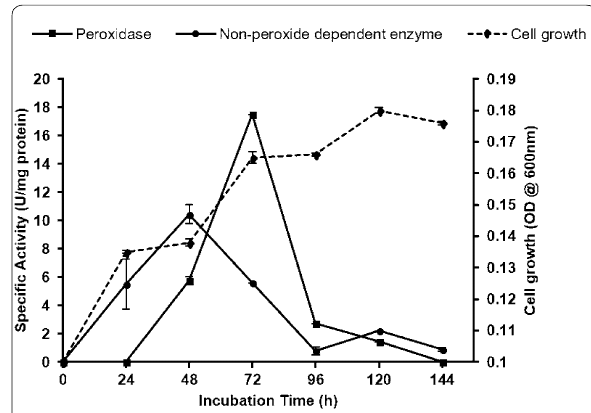
Fig. 6 Time course of peroxidase and non-peroxidase activity expression by